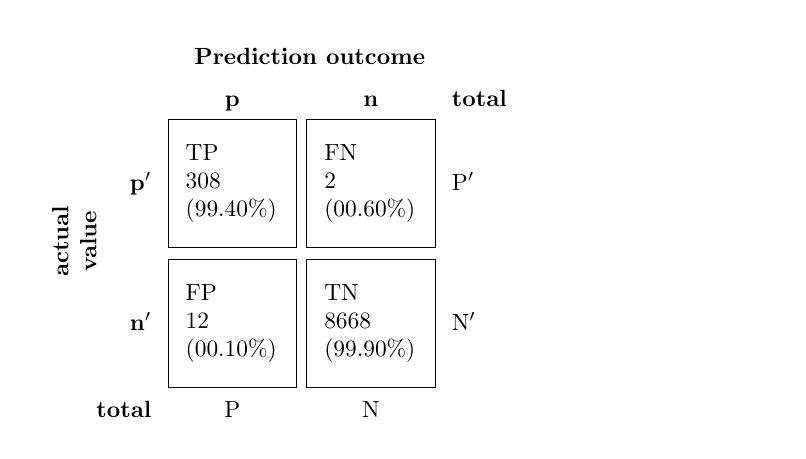
Figure 13. The confusion matrix of our detection system which achieved an accuracy of